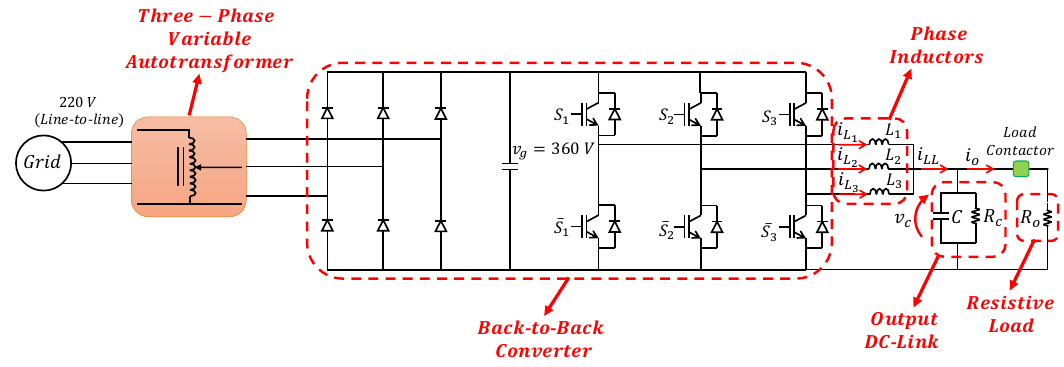
Figure 19. Experimental setup diagram.